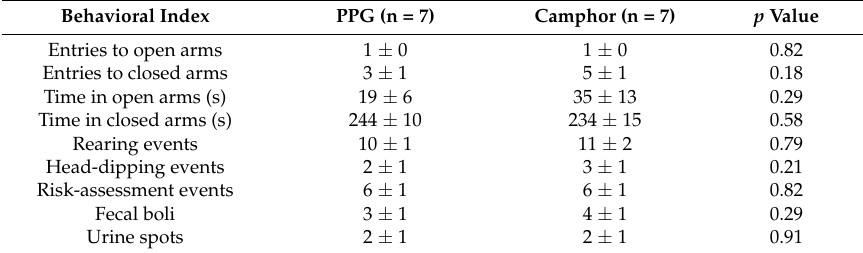
Figure 2. Effect of camphor on T b ( A ), T sk ( B ), and grooming ( C ). Camphor, a nonselective transient receptor potential (TRP) agonist, when applied epidermally (e.d.; dose indicated), did not alter T b or T sk , but increased the time spent self-grooming, as compared to vehicle (polypropylene glycol, PPG). The experiments were conducted at neutral T a of 26 ◦ C. An asterisk (*) indicates a significant difference ( p < 0.05), as compared to PPG-treated rats. Table 1. Effects of camphor or its vehicle (PPG) on behaviors in elevated plus